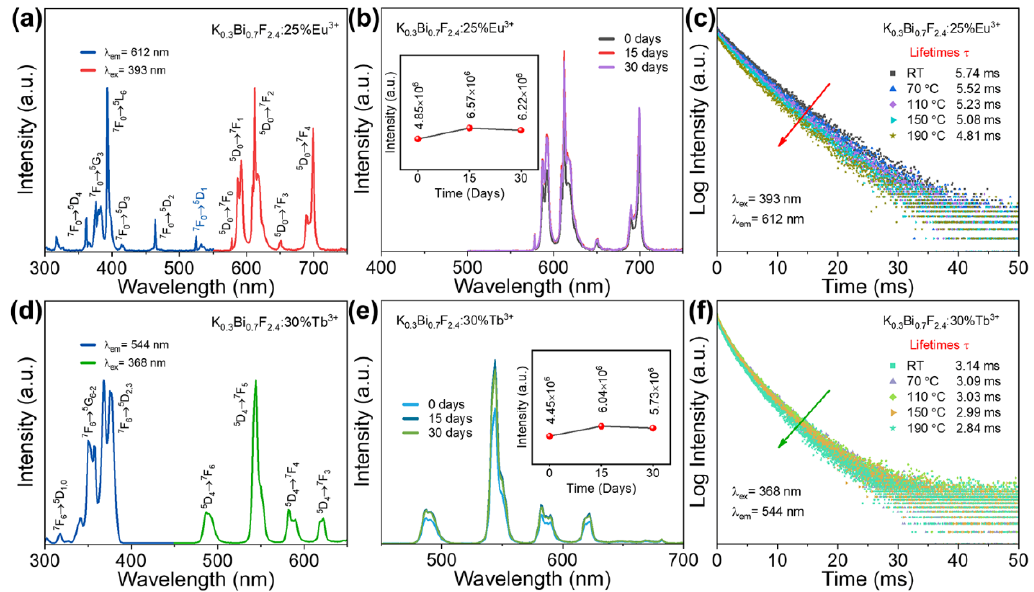
Figure 6. Photoluminescence properties of KBF:25%Eu ( a – c ) and KBF:30%Tb nanocrystalline particles ( d – f ).